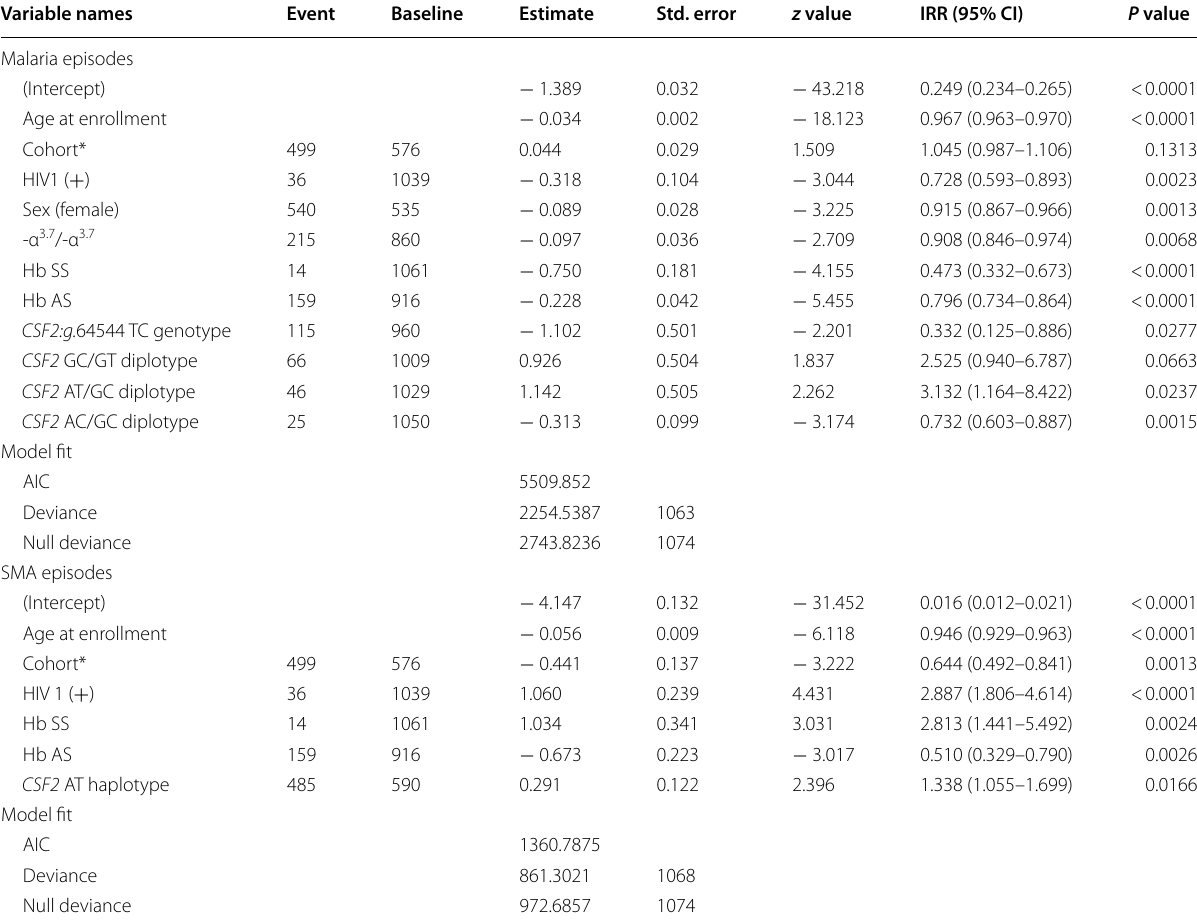
Table 3 Rate of malaria and SMA